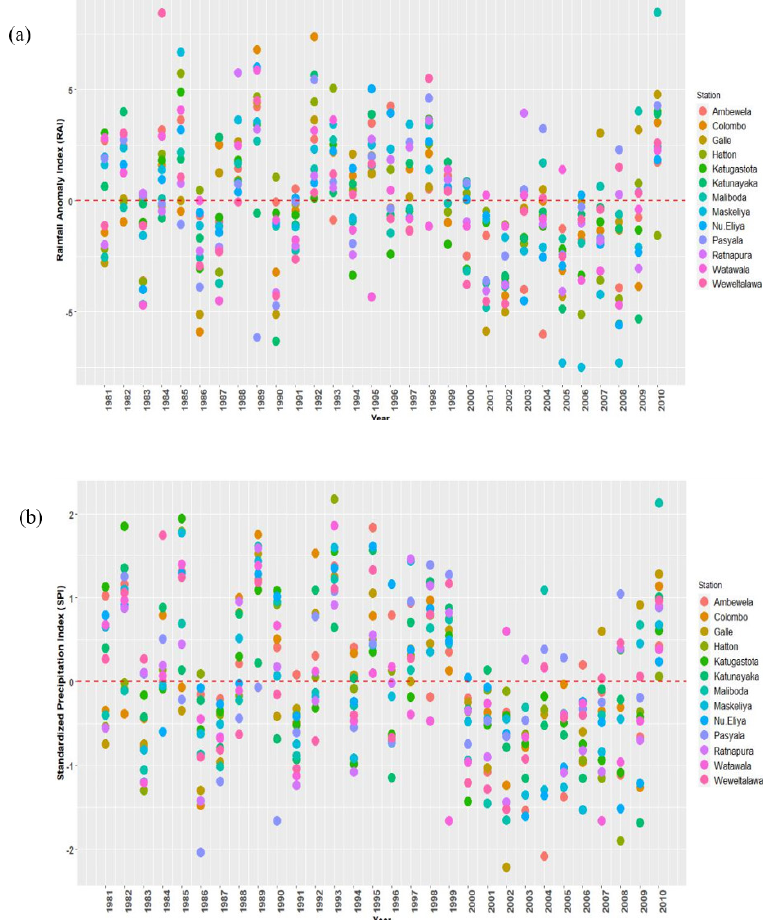
Figure 3: Values obtained for (a) RAI and (b) SPI for 13 rain gauge stations during 1981 -